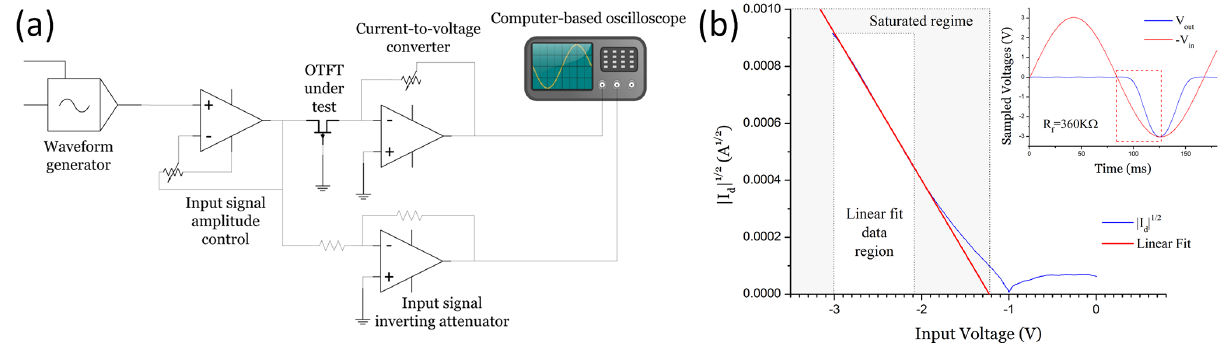
Figure 1. (a) A simplified schematic of the circuit for real-time measurements. (b) Inset: plot of − V in (red sine) and V out (blue) versus time, showing “on” and “off” half-cycles. Main plot: saturated transfer characteristic (blue) in the form square root of modulus of drain current versus applied voltage ( − V in ). Same data as in the inset, but time is eliminated. Red straight line: linear fit to high drive voltage data for evaluation of mobility and